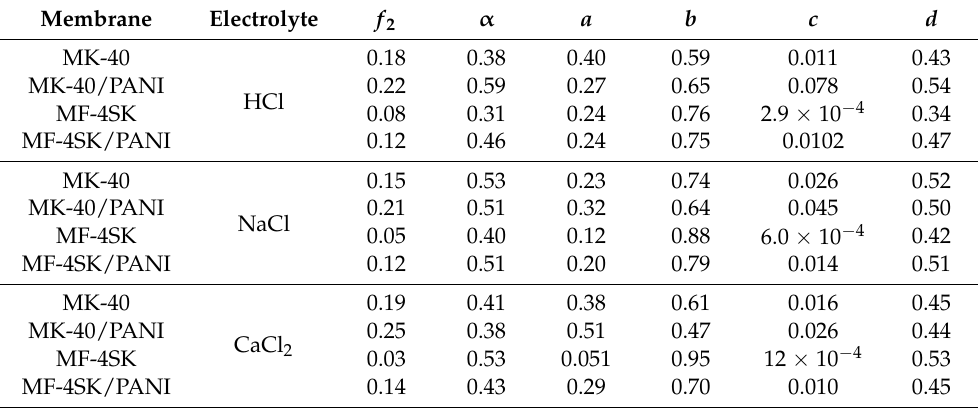
Table 2. Transport-structural parameters of the extended tree-wire model.